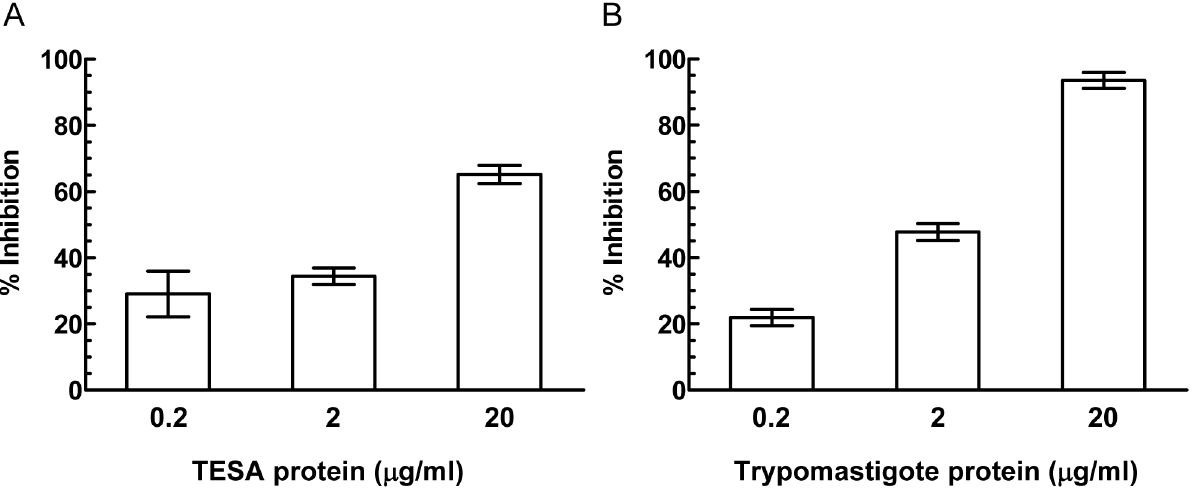
Figure 6. Competition with TESA and trypomastigote protein extract demonstrates that Apt-L44 binds to a parasite biomarker. Parasite protein were diluted at concentrations of 0.2, 2 and 20 m g/ml and incubated with 5 nM biotinylated Apt-L44. Plasma from infected mice, coated at 1:200 dilution in a polystyrene 96 well plate, was then interrogated with the aptamer-protein mix and ELA assay performed. Wells with biotinylated Apt-L44 alone was considered 100% binding and percent inhibition calculated as described in the methods section. The percent inhibition was plotted on the Y-axis with each bar representing the mean % inhibition achieved, with standard deviation, from duplicate wells. ( A ) In the presence of TESA, biotinylated aptamer is sequestered by its target and cannot interact with the target present in the coated plasma, causing a decrease in signal levels represented by % inhibition. ( B ) Trypomastigote parasite proteins also showed a similar result as TESA and this suggested that Apt-L44 bound to a parasite specific biomarker circulating in the blood of T. cruzi infected